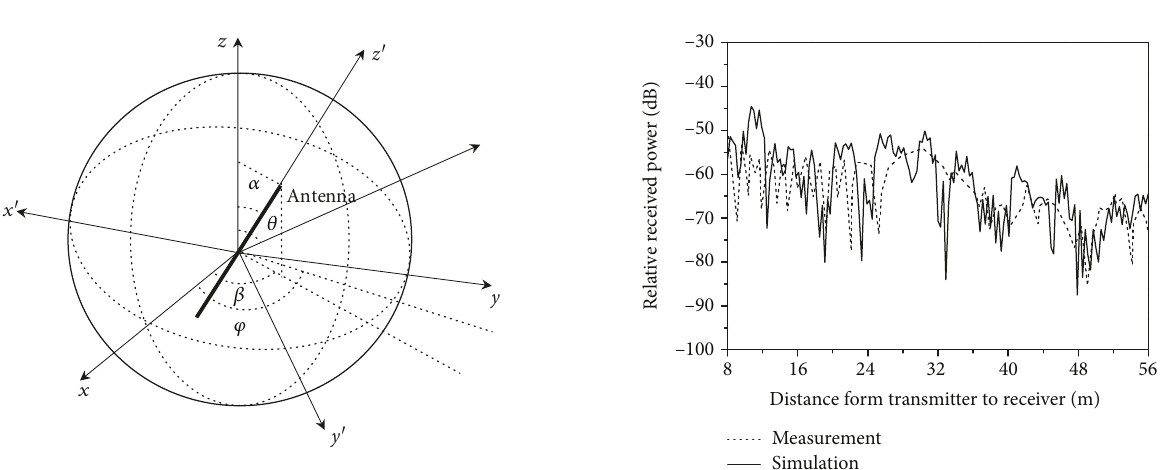
Figure 4: The demonstration of two coordinate systems. x - y - z is the global coordinate system, and x ′ - y ′ - z ′ is the local coordinate system. Figure 5: The relative received power from A to B in the LOS corridor ( N = 10 , M = 8 , G T = 1 dBi, and G R = 1